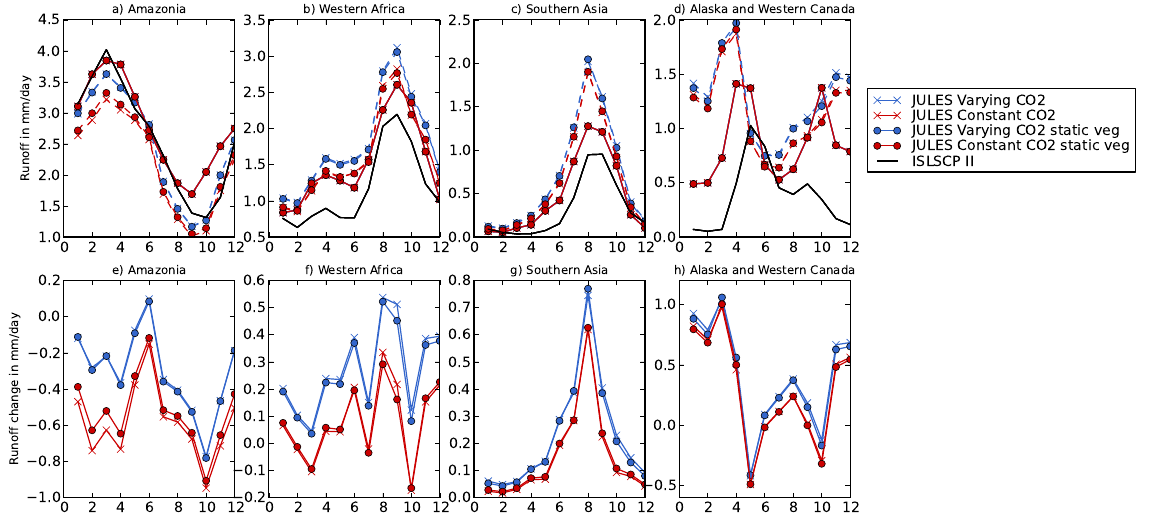
Fig. 8. Annual cycles of runoff for selected Giorgi regions using sensitivity experiment runs from JULES forced with HadGEM2-ES RCP8.5 climate: (a–d) : absolute values for 1981–1990 (solid lines) and 2081–2090 (dashed lines); (e–h) : absolute changes between 1981–1990 and